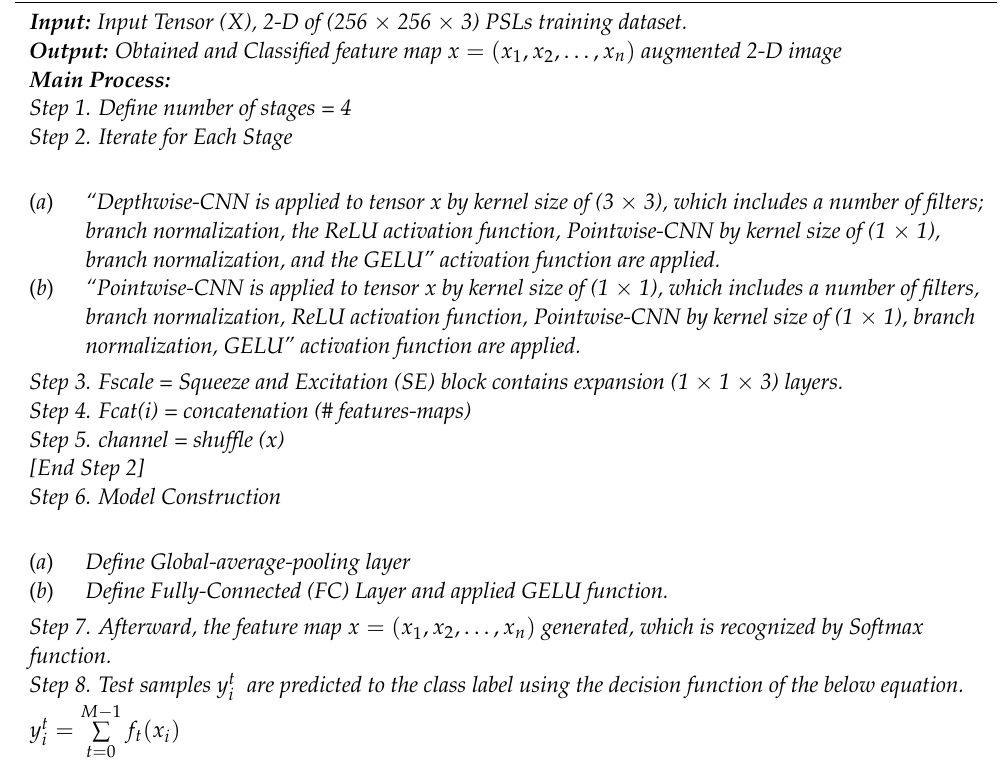
Algorithm 1 : ShuffleNet-Light Architecture for Features Extraction and Classification of